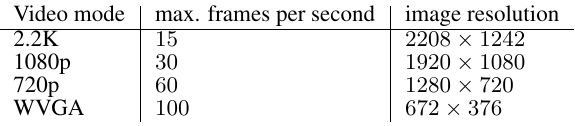
Table 1. Supported resolutions and refresh rates of the ZED